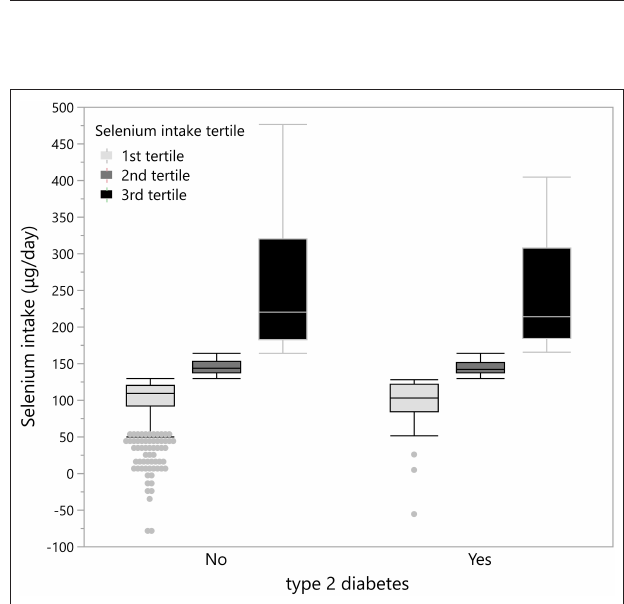
FIGURE 2 | Distribution of participants according to tertile of energy-adjusted Se intake.